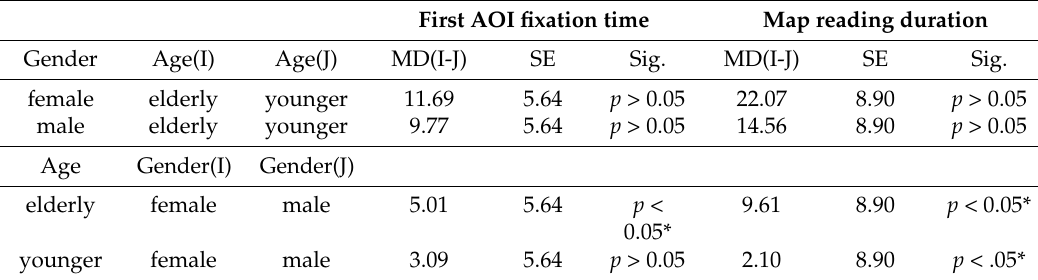
Table 3. Simple Effects Test for Task 1